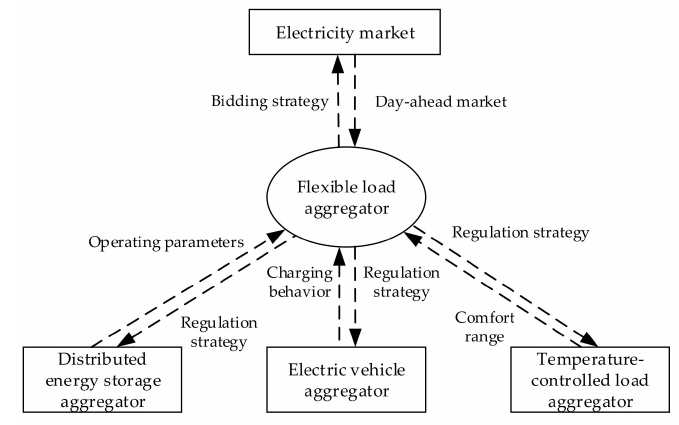
Figure 2. Diagram of flexible load aggregators participating in the